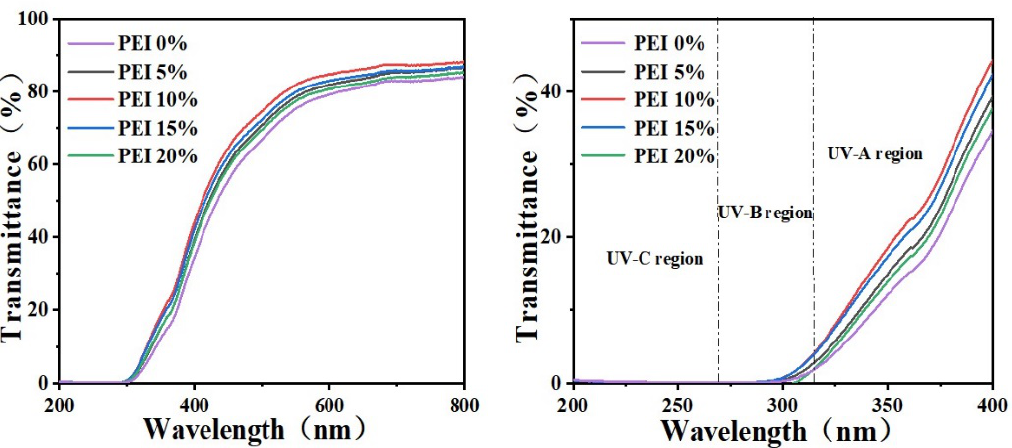
Figure 4. UV-vis spectra of the composite films. Figure 4. UV − vis spectra of the composite fi lms. Figure 4. UV − vis spectra of the composite fi lms.